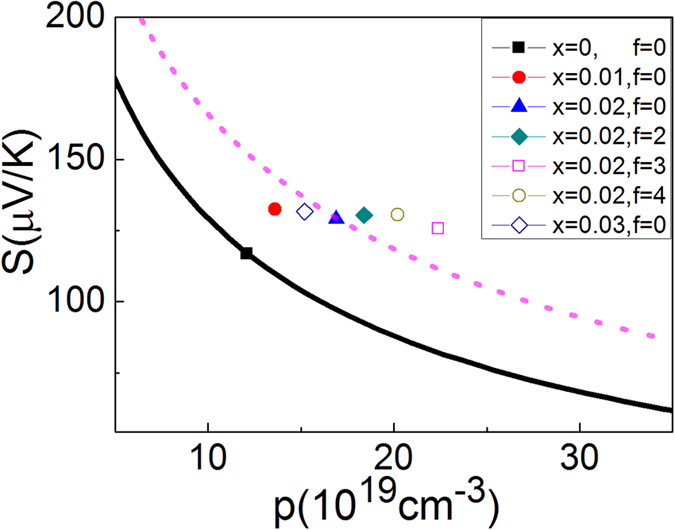
Variation of thermopower with carrier concentration of β-(Zn1-xPbx)4Sb3 (0.01, 0.02, and 0.03) and f(Cu3SbSe4)/β-Pb0.02Zn3.98Sb3 (f = 2, 3 and 4 vol.%) at 300K.The black solid and pink dashed lines represent the carrier concentration dependence of thermopower (Pisarenko relation) of β-Zn4Sb3 using md* = 1.51me and β-Pb0.02Zn3.98Sb3 using λ = 0, respectively.